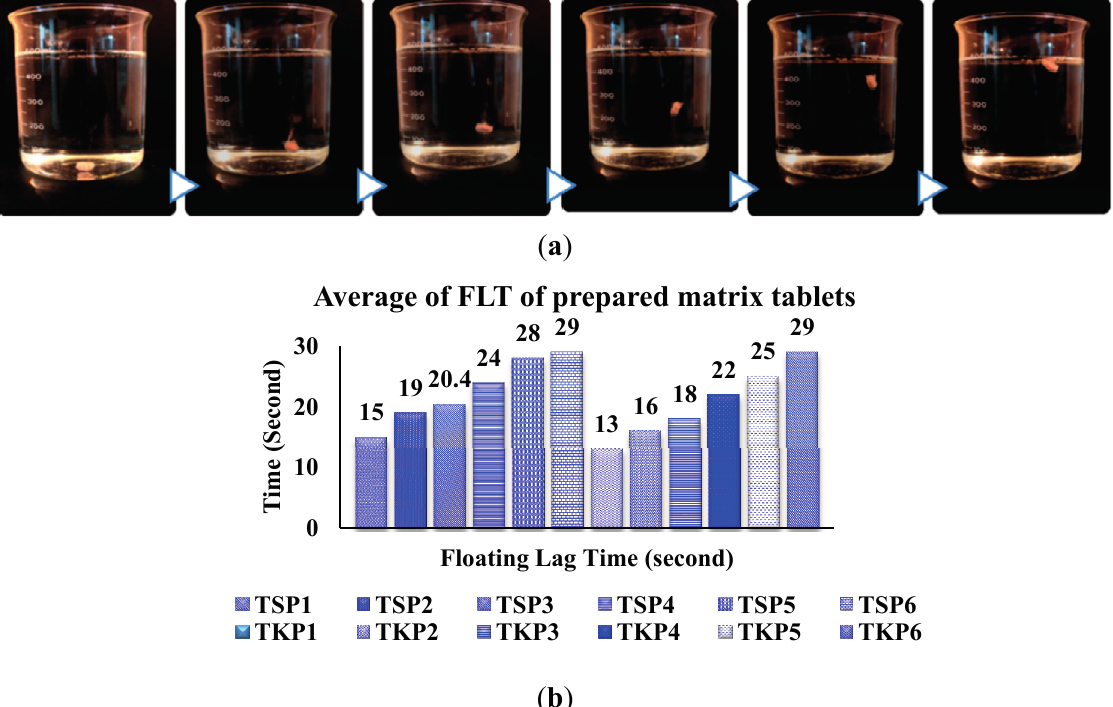
Figure 6. ( a ) Floating of famotidine matrix tablet (TKP2); ( b ) Floating lag time of different formulations of TKP and TSP with equal concentrations of NaHCO